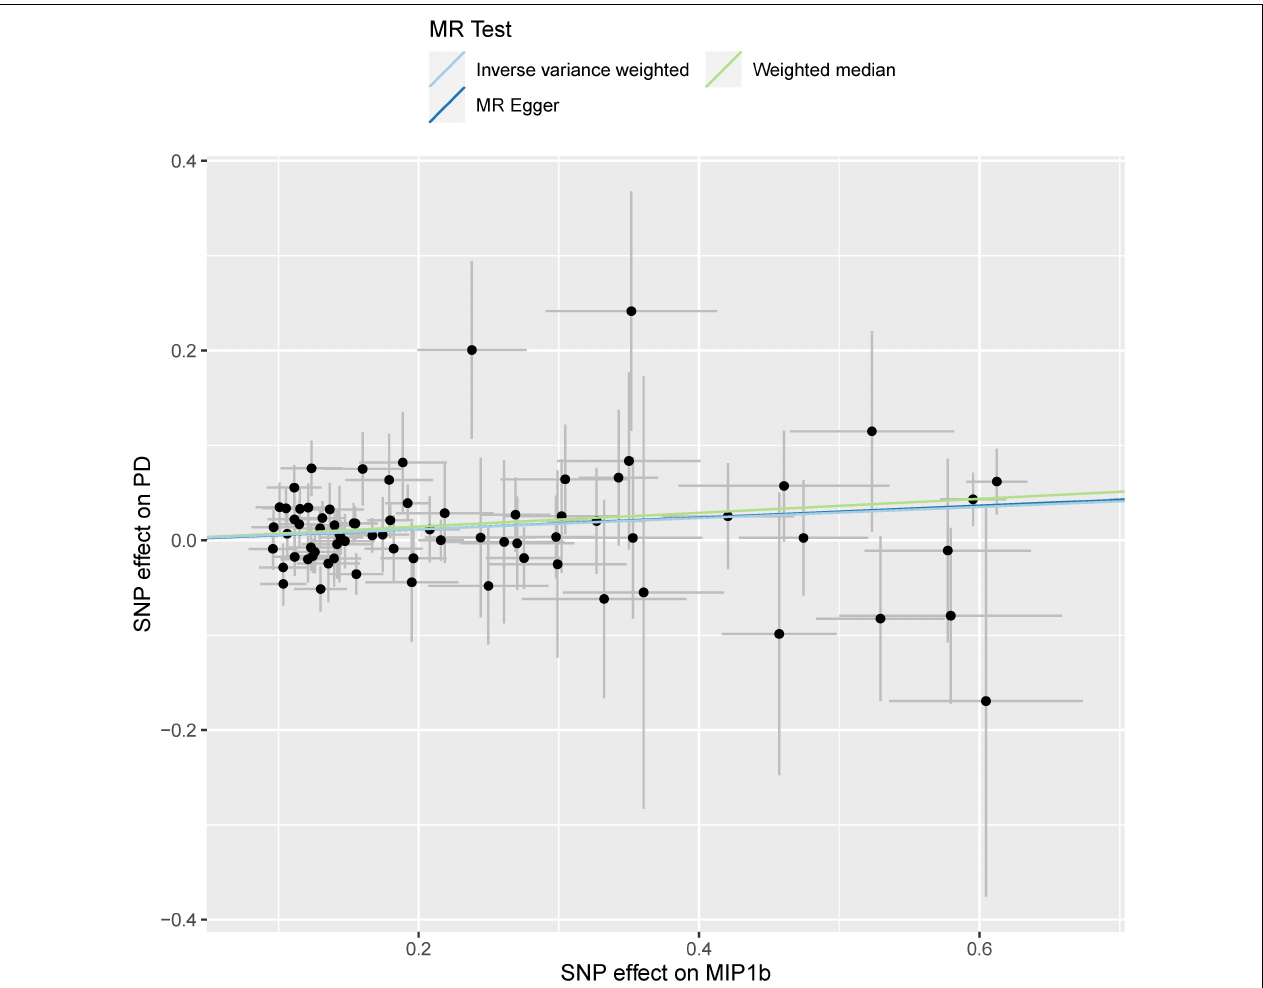
FIGURE 2 | Scatterplot of genetic association with circulating levels of MIP1b against the genetic association with PD risk. Each black dot indicates an SNP, plotted by the estimate of SNP on the MIP1b levels and the estimate of SNP on PD risk with standard error bars. The slope of the line represents the causal relationship, and each method has a different line. PD, Parkinson’s disease; SNP, single-nucleotide polymorphism.